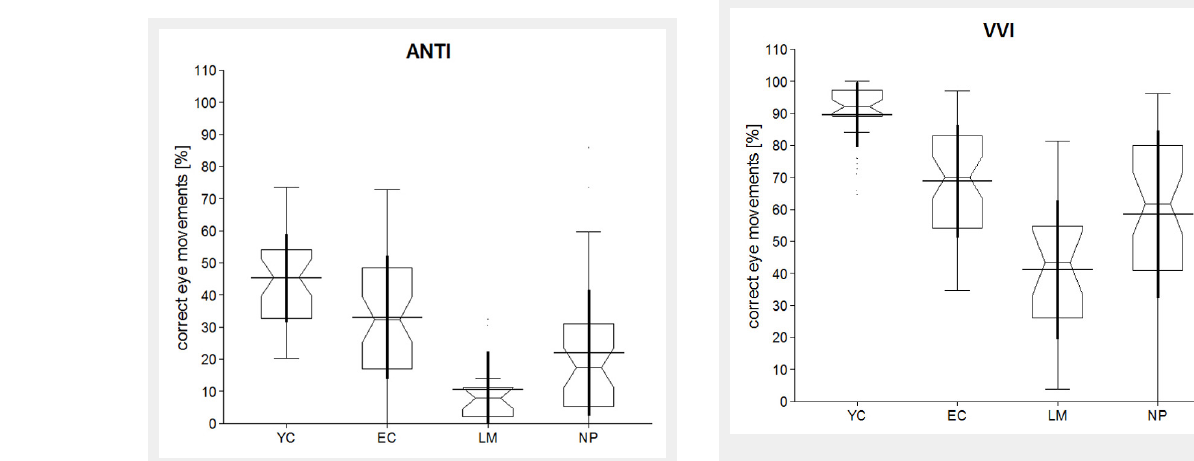
Evaluation of all prosaccades for all groups. The percentage of correctly performed eye movements is presented; boxes indicate the distribution of the data include mean and SD (thick line), median, confidence intervals (5%, 95%) and outliers (single dots). EC = elderly comparison group; LM = patients at the Department of Legal Medicine; NP = patients at the Department of Neurology; YC = young comparison group